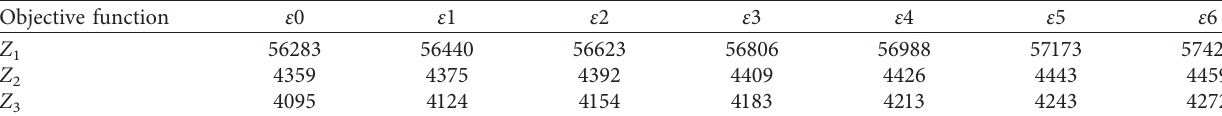
Table 9: Pareto solutions of objective